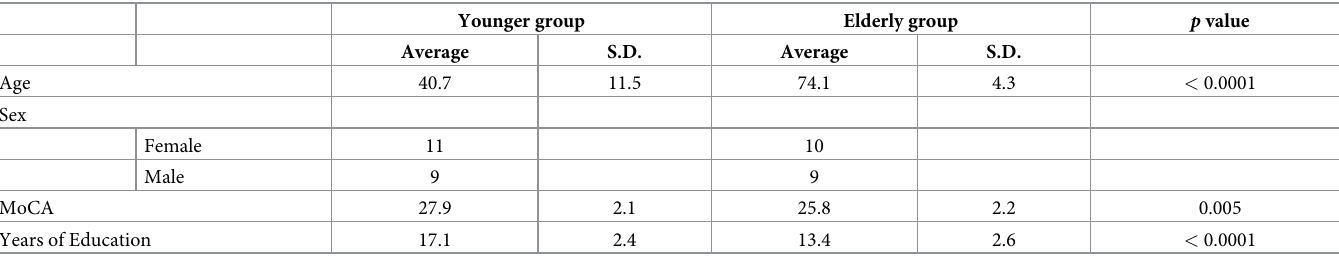
Table 1. Participants